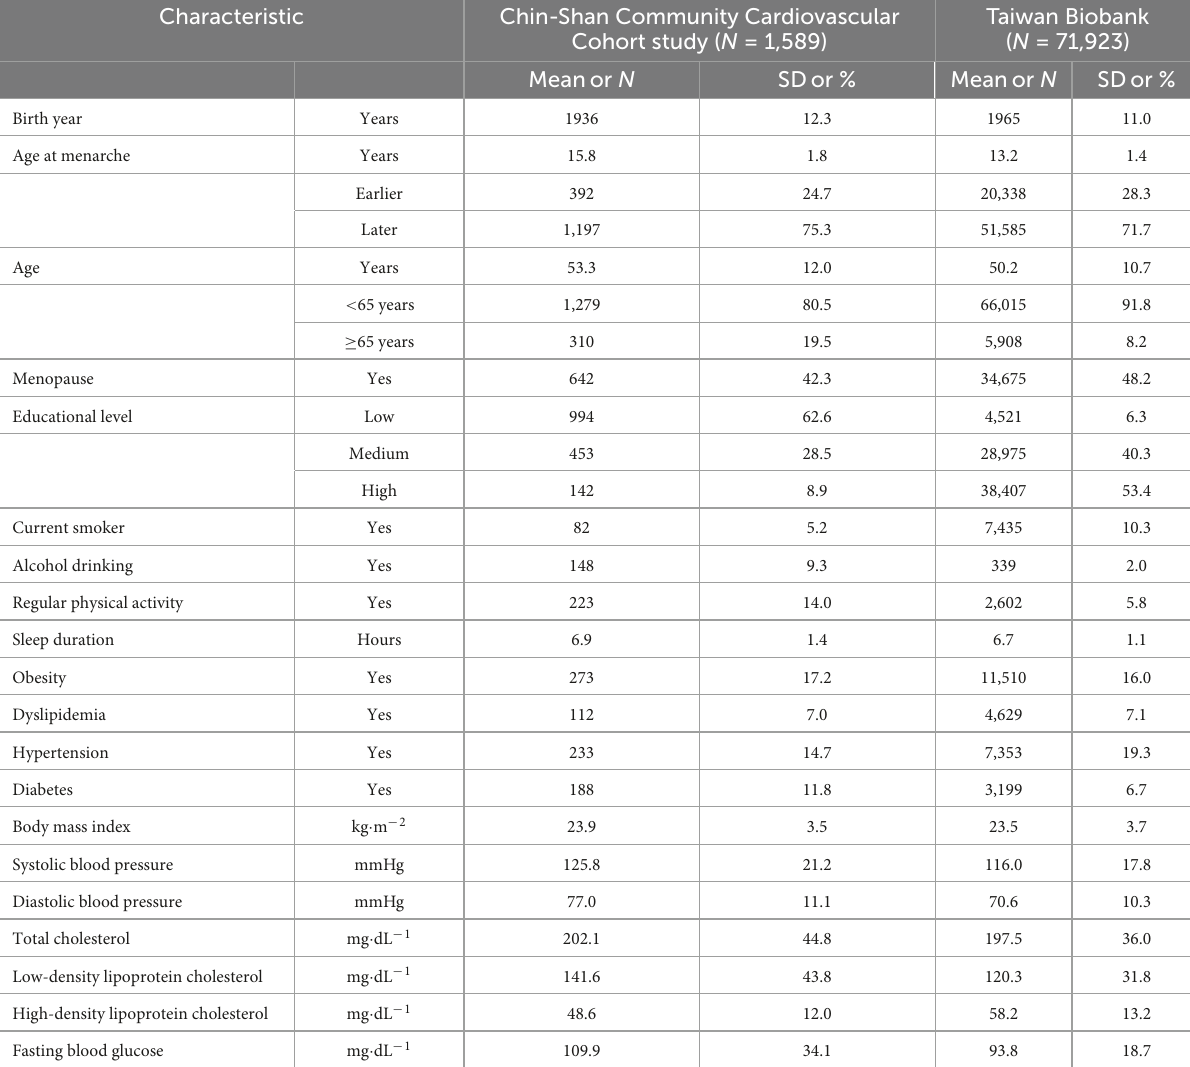
TABLE 1 General characteristics of participants in the Chin-Shan Community Cardiovascular Cohort and Taiwan Biobank.